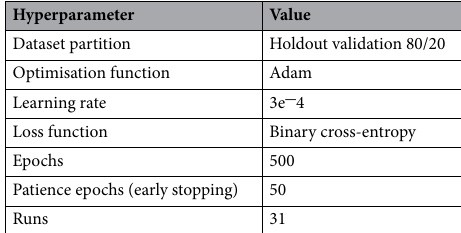
Table 1. Hyperparameters used to train the neural